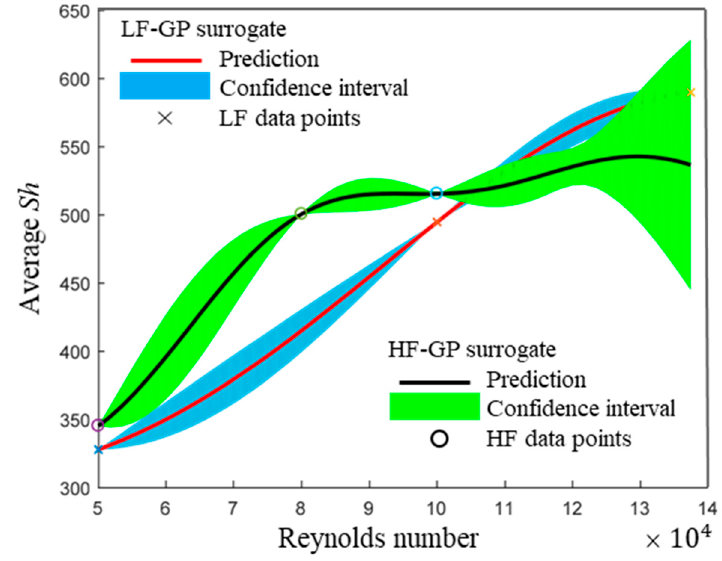
Figure 6. 1D projection of LF-GP and HF-GP surrogate for a fixed BL thickness of 10 mm.